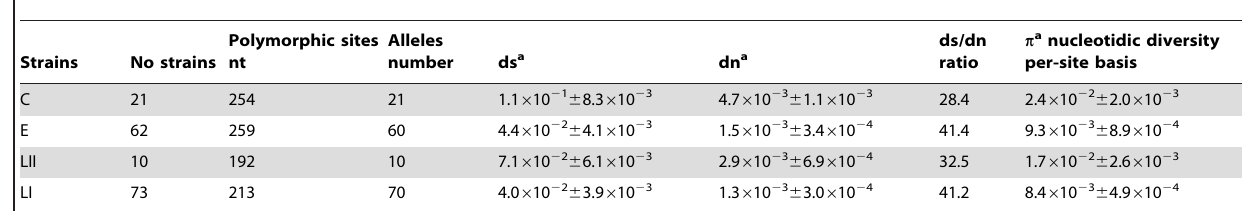
analyzed in the present study present a purifying selection with ds/ dn ratio much higher than 1 (range between 14.1 for vvhA and 38.8 for gyrB ). These results are consistent with other MLST studies of V. vulnificus [14,18]. Table 3. Comparison of genetic parameters of lineages LI and LII from MLST, and of clinical and environmental strains.